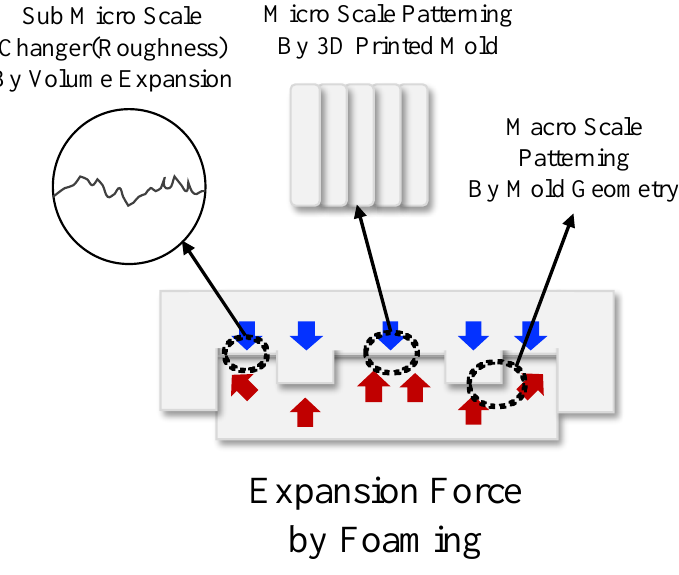
Figure 10. Schematic for the three-stage solid-state surface-patterning process.